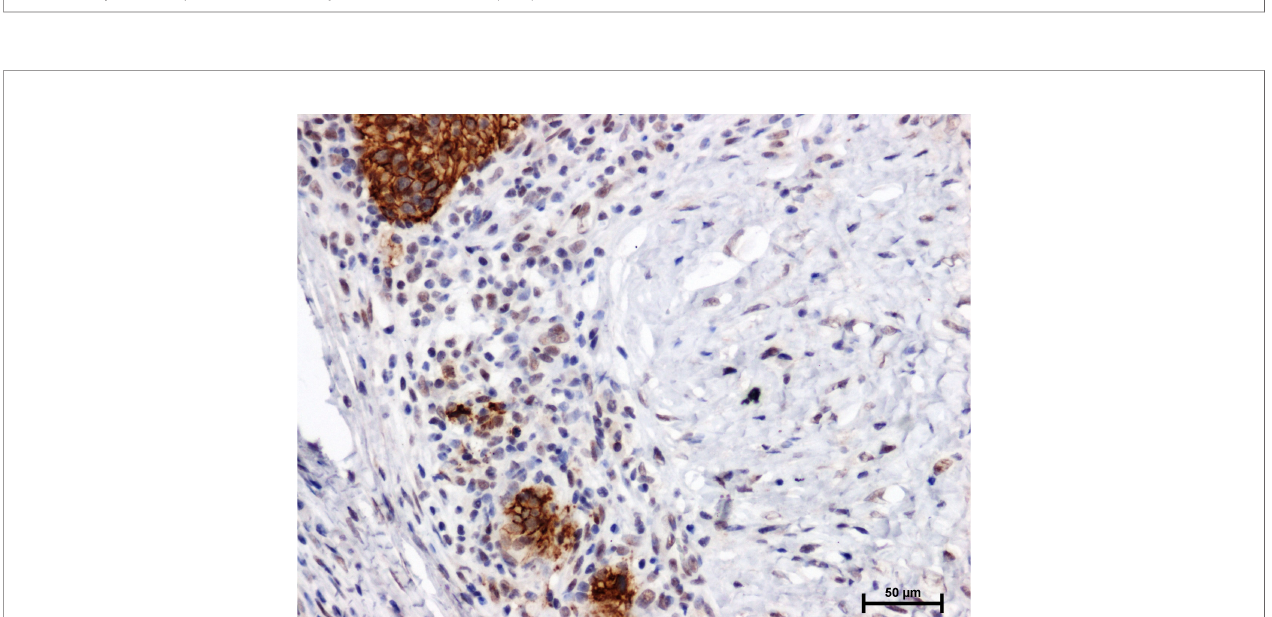
FIGURE 2 | Immunoidenti fi cation of E-cadherin in warty – basaloid carcinoma of